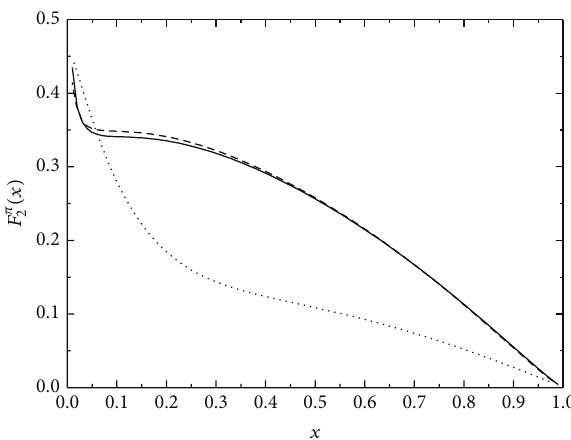
Figure 4: The structure function of pion. The full and dashed curve are the GRV’s LO and NLO pion structure function. The dotted line is the structure function calculated according to equation of 𝐹 𝜋 2 (𝑥) in